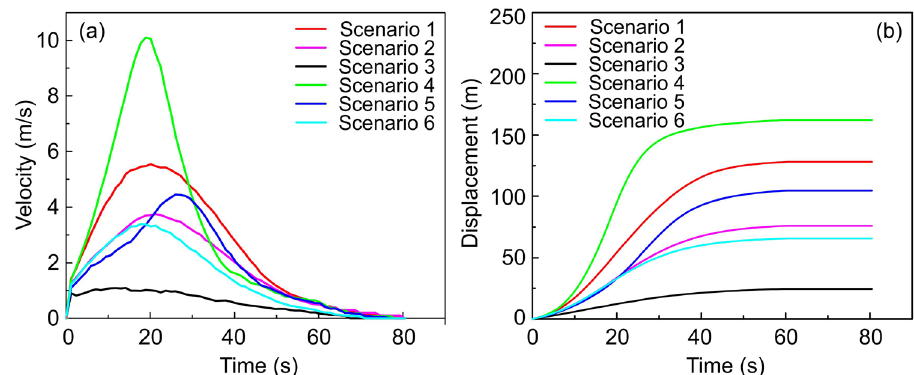
Fig. 5 Landslide velocity and displacement results for dif- ferent simulation scenarios. a Average velocity; b average